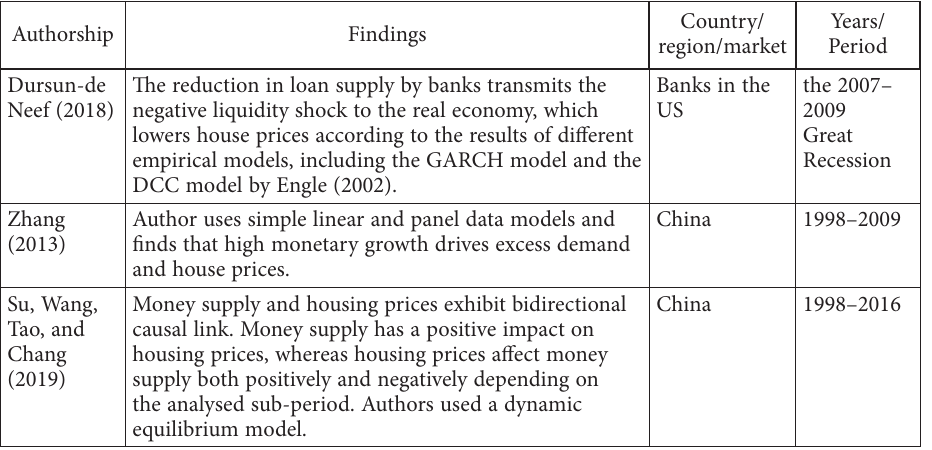
Table 1. Money/credit vs. house prices – a literature review (source: own